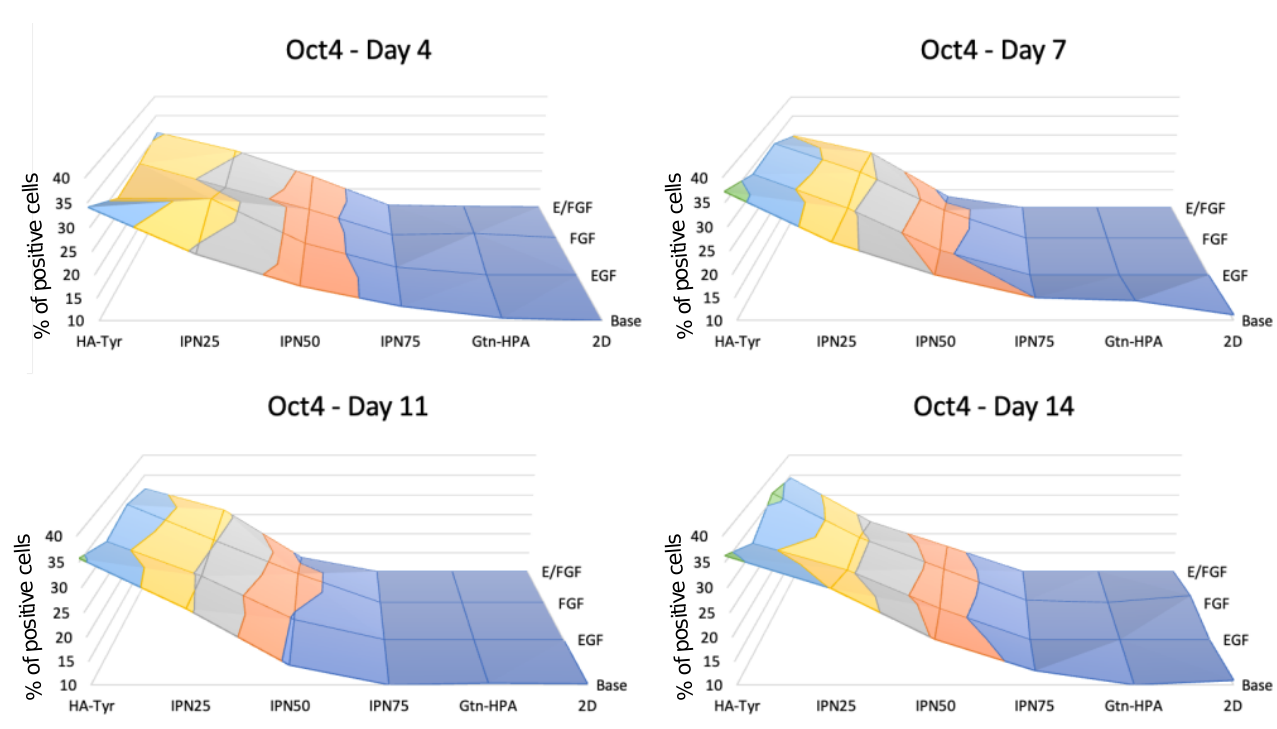
Figure 5. Stemness expression (Oct4) in hRPCs in different tissue culture. Cells were cultured for 2 weeks and phenotype was analyzed at day 4, 7, 11, and 14 for n = 5 replicates with flow cytometry. Map surfaces show the medium component on the x -axis (base medium, EGF, FGF, or both), the tissue culture on the y -axis (2D, Gtn-HPA, IPN75, IPN50, IPN25, and HA-Tyr) and the expression of Oct4 is shown on the z -axis.